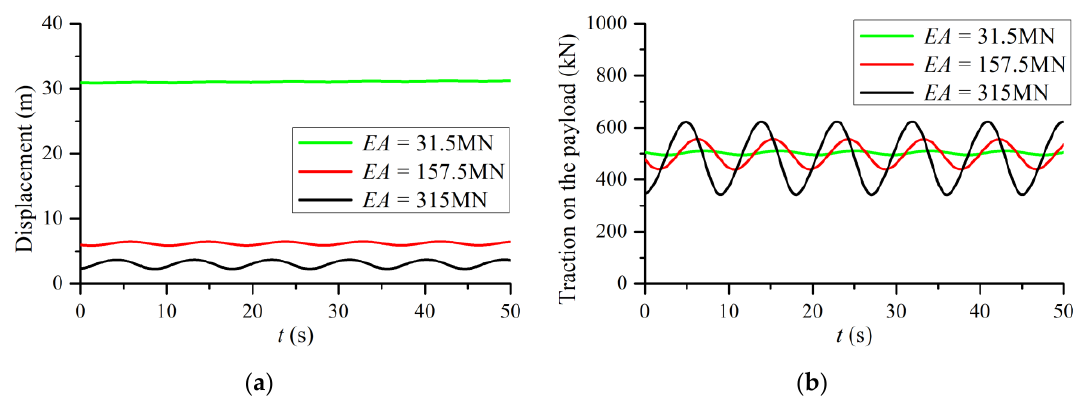
Figure 13. Comparison of the payload’s response with different cable stiffness coefficients for 1500 m depth: ( a ) motion of the payload, ( b ) traction on the payload.